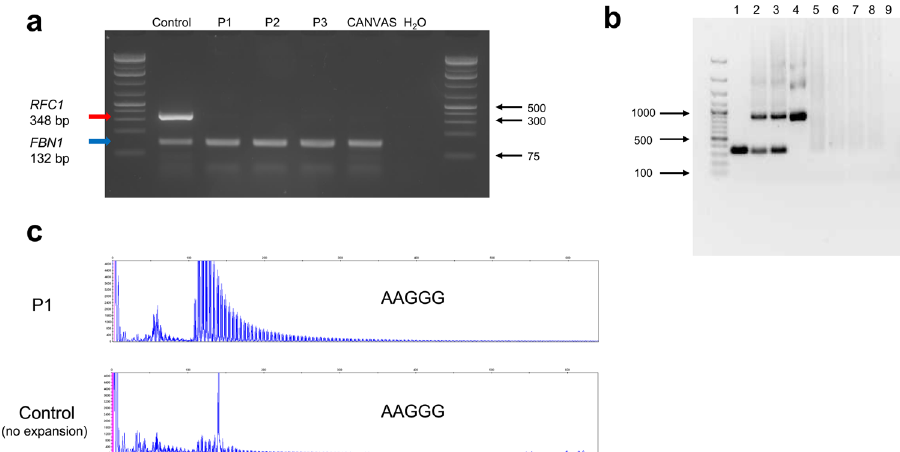
Fig. 1 Detection of (AAGGG)exp in RFC1. a Multiplex PCR of RFC1 and FBN1 shows no RFC1 PCR product in the region of interest in the three patients with PD (P1-P3) or CANVAS. The gel derives from the same experiment. b XL-PCR ampli fi cation of RFC1 carried out with Phire II Hot Start DNA polymerase. Lanes 1 – 4, healthy controls with normal fragment size variation; lanes 5 – 7, patients 1 – 3; lane 8, patient with CANVAS and biallelic (AAGGG)